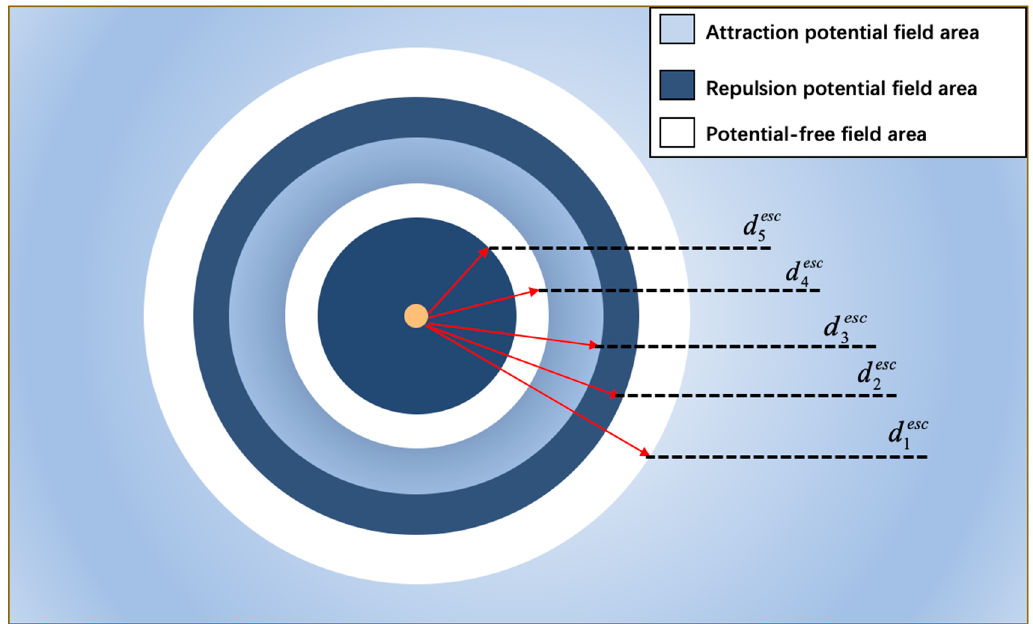
Figure 2. An illustration of the potential field configuration.